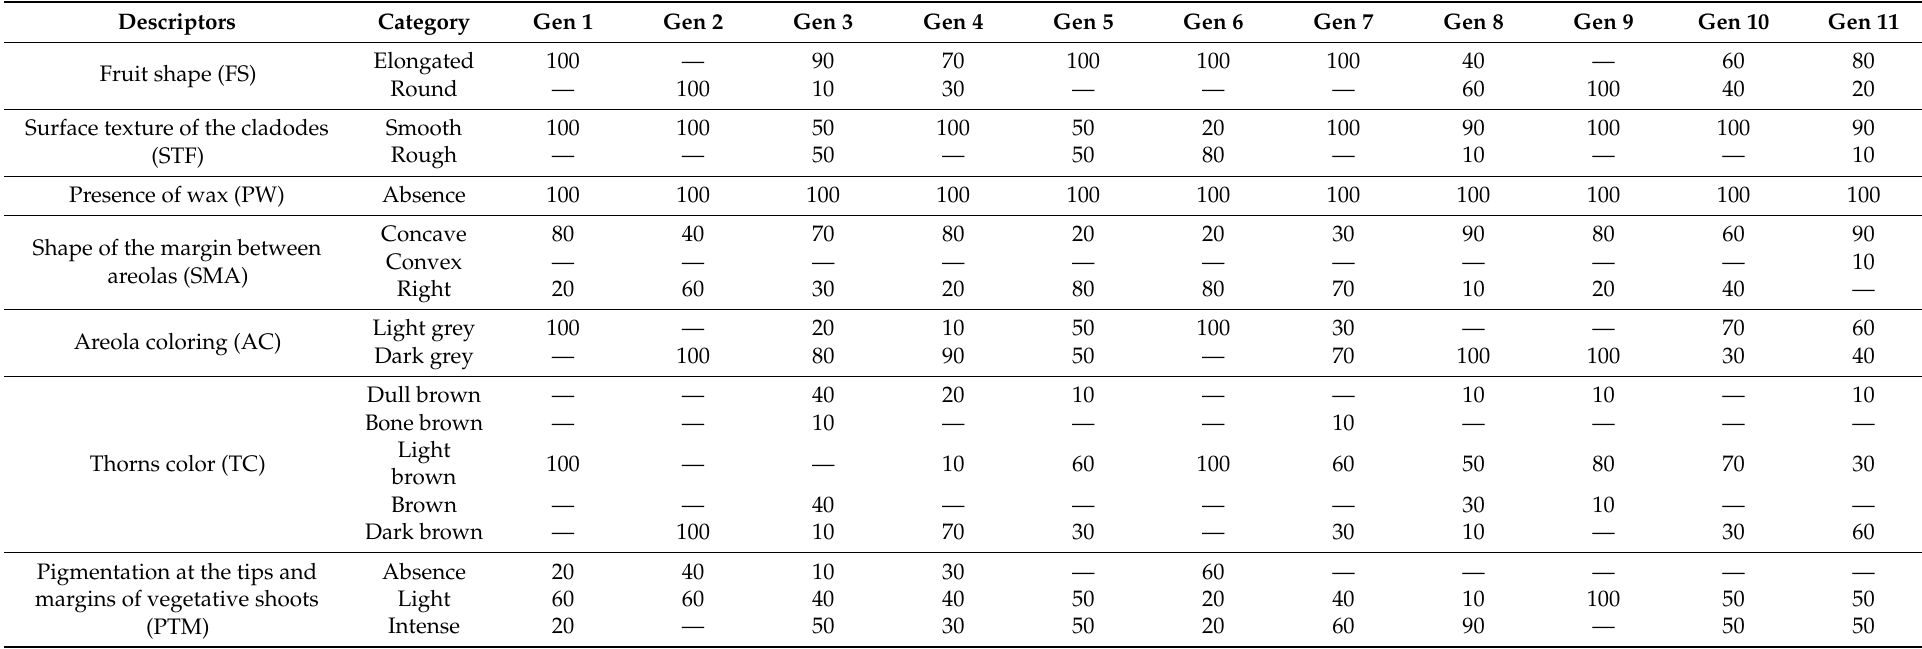
The values indicate the percentage of introductions that present the respective